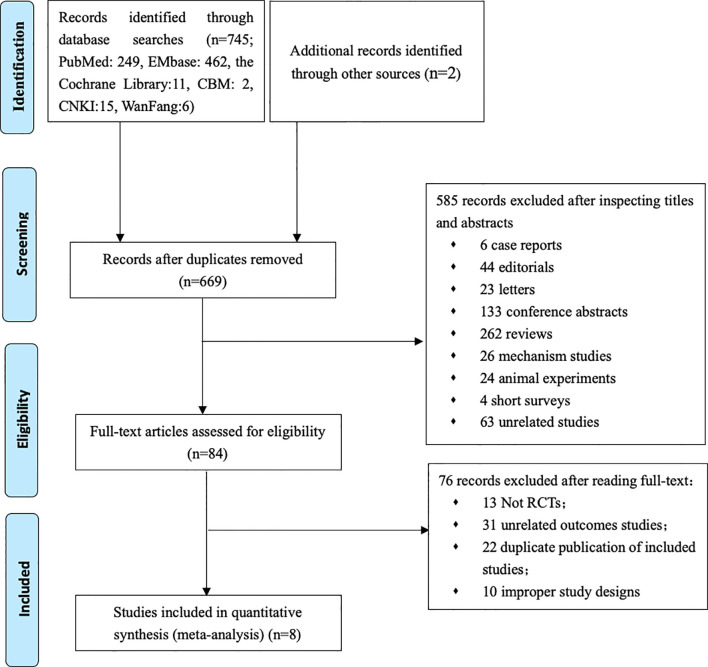
Flow chart of study selection.